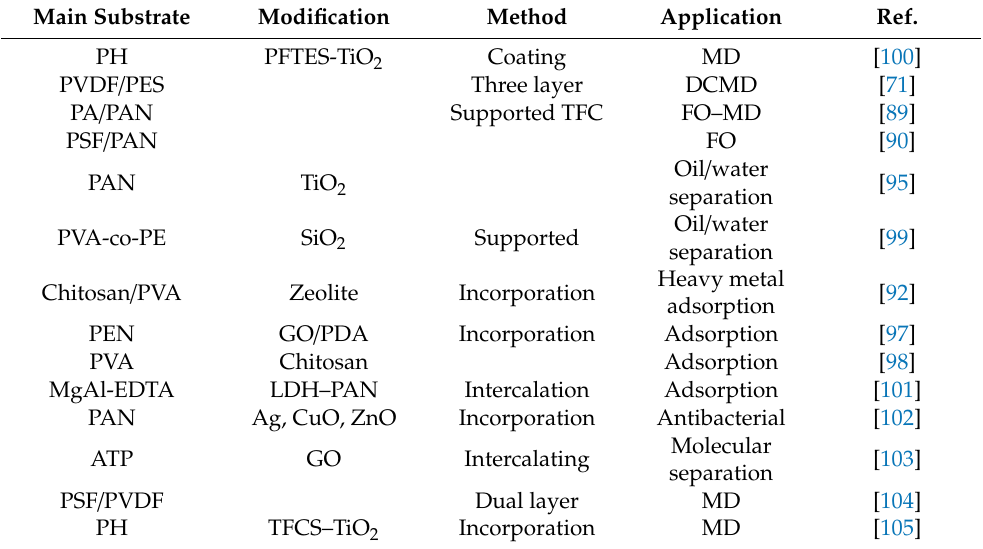
Table 1. Nanofiber composite membranes used for membrane separation and water purification